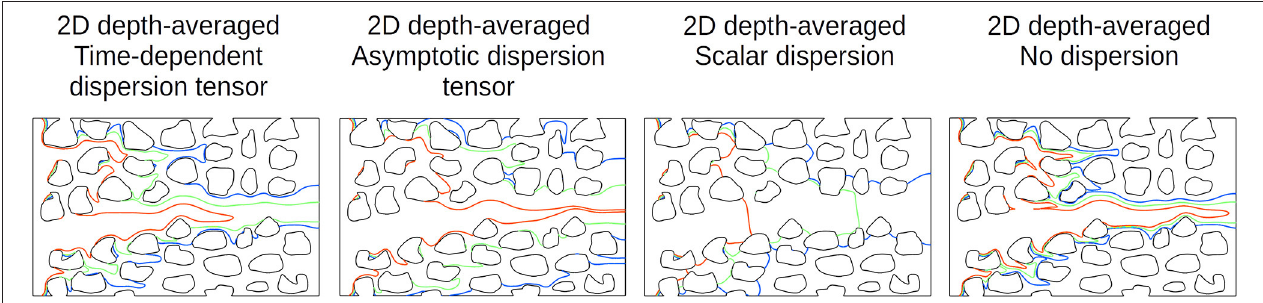
FIGURE 4 | Comparison of the transport of a scalar at Pe = 10 3 in a micromodel with aspect ratio h / d > 1 using 2D depth-averaged models including time-dependent dispersion tensor, the asymptotic dispersion tensor, isotropic dispersion, and no dispersion. The results correspond to isocontour of the concentration for C = 0.2 (blue), C = 0.5 (green), C = 0.8 (orange) at t = 42s. Neglecting the dispersion [i.e., D( t ) = D i I] or considering only the asymptotic Taylor-Aris ] tends to overdisperse the solute. Isotropic dispersion cannot capture the transport of scalars in dispersion [i.e., D( t ) = D i I + h 2 v 2 D v 2 D 210 D i